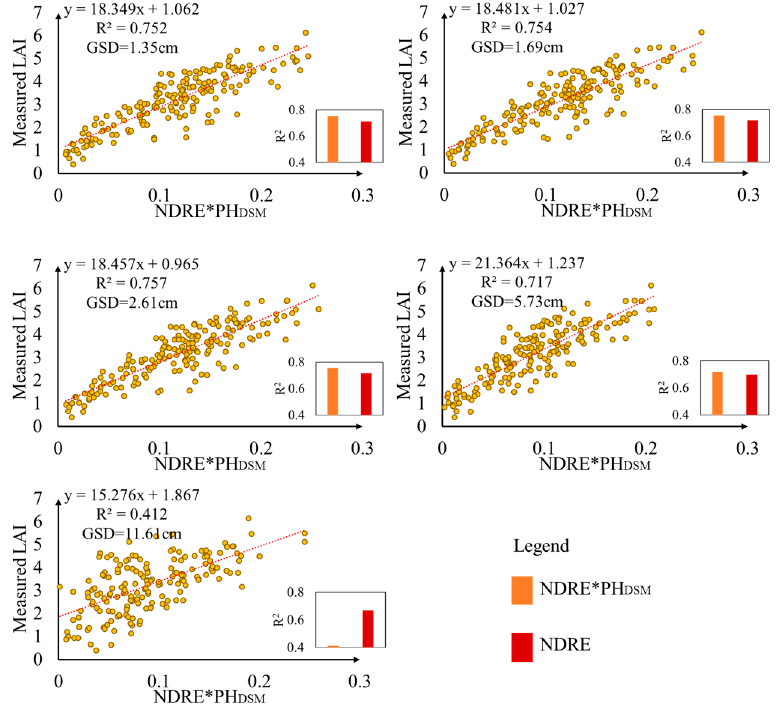
Figure 9. LAI estimation by NDRE*PH DSM and NDRE. The scatter plots and regression lines show the relationship between NDRE*PH DSM and ground-measured LAI. The histograms show the R 2 values between ground-measured LAI and either NDRE*PH DSM or NDRE at different GSDs.